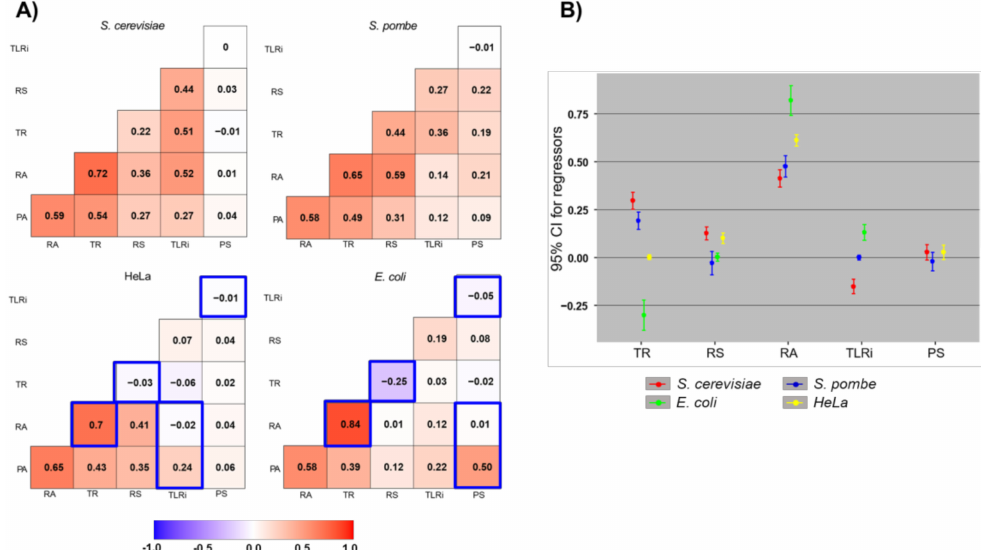
Figure 2. Correlations between the six variables of the gene expression in four model organisms. ( A ) The pairwise Pearson’s correlations among the six variables in each organism. Exact values are indicated in frames. The background color scale indicates positive (red) or negative (blue) correlations. Some correlations are less reliable because they are between the variables calculated from some others in HeLa and E. coli (see the main text) and are marked with blue boxes. ( B ) Estimation of the coefficients of a multiple regression model per organism using Bayesian model averaging (posterior mean and 95% credible interval). These coefficients show the contribution of each variable across organisms to the final protein amount (PA) using a Z-score scale to make them comparable. The TLRi for HeLa and the PS for E. coli are not shown because they were mathematically calculated from PA values (see Materials and